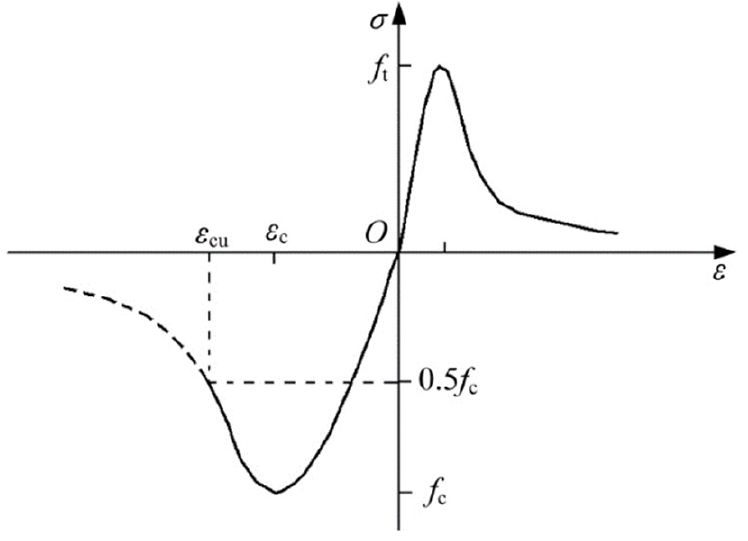
Figure 1. Constitutive relation of